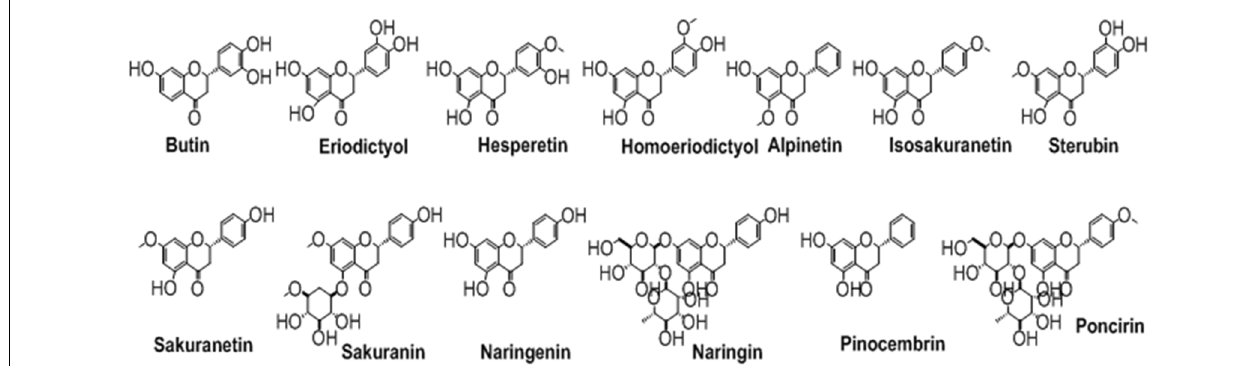
FIGURE 6 | The chemical structures of important isolated flavanones.